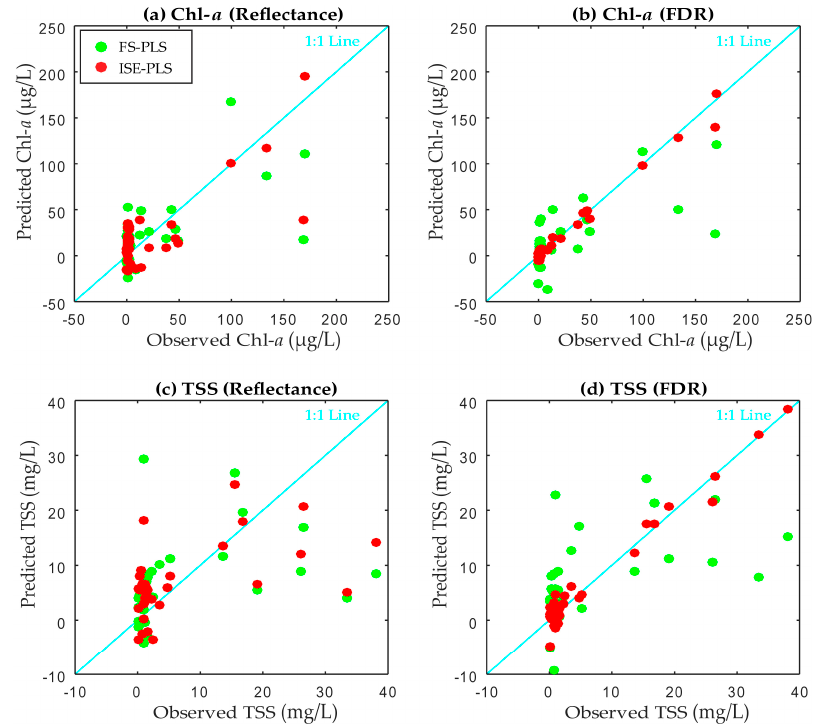
Figure 4. Relations between measured and cross-validated prediction values of Chl- a ( a ) Reflectance; ( b ) FDR and TSS; ( c ) Reflectance; ( d ) FDR using FS–PLS and ISE–PLS.